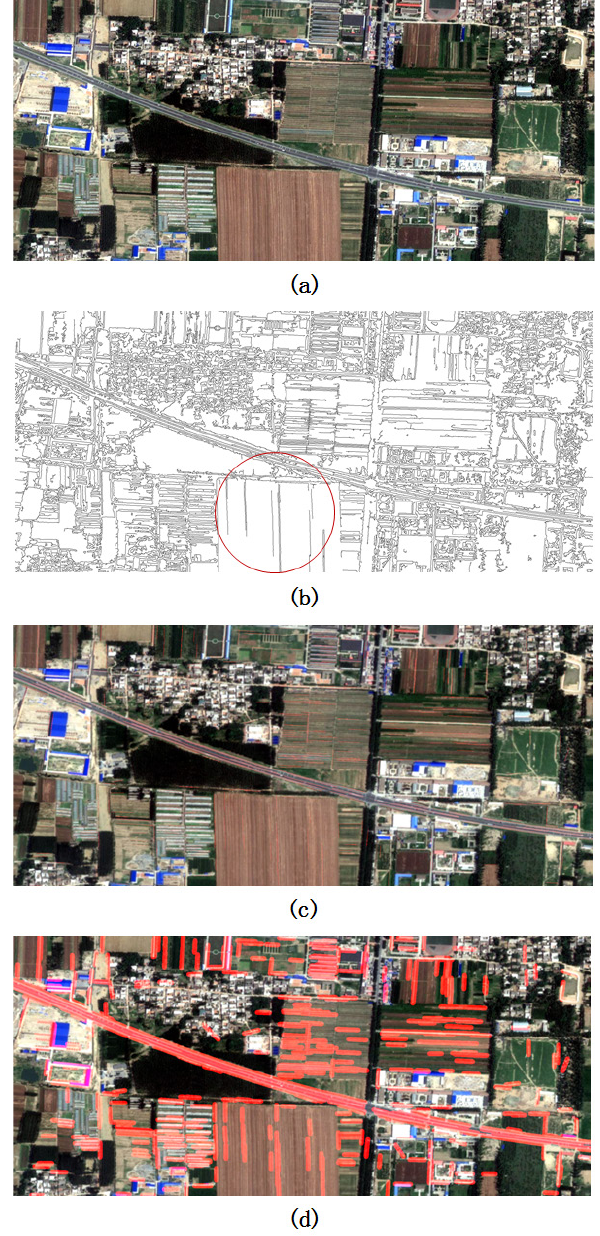
Figure 2. (a)Original image(b)Canny edge detection(c)Hough line segments detection(d)Hough line buffer